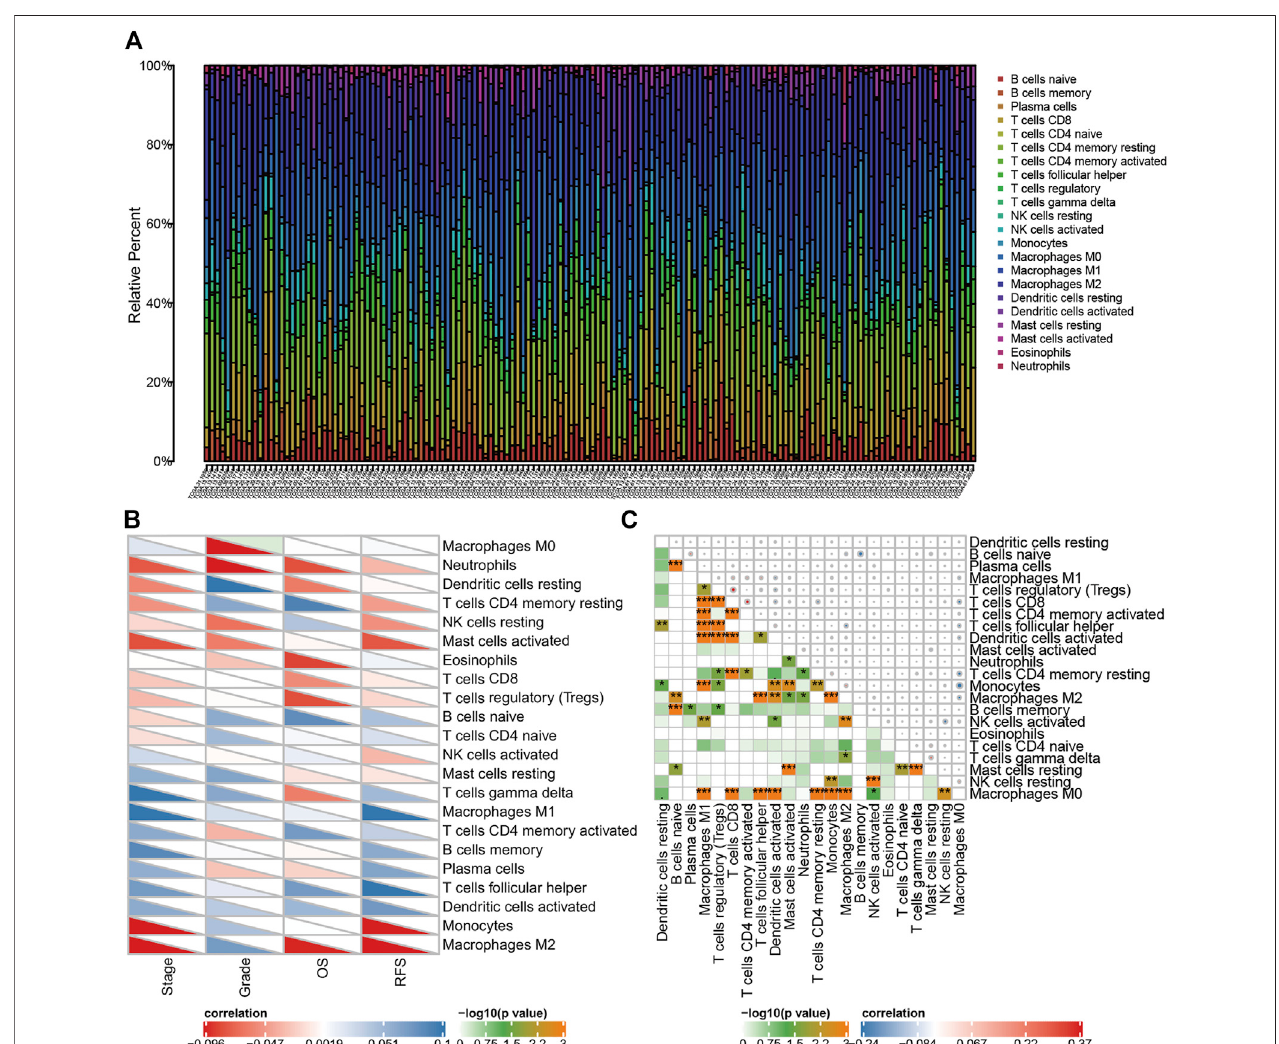
FIGURE2| Distribution oftumor immunecellsinOCpatients,and therelationshipbetweenimmune in fi ltrationcellsandclinicalfeatures. (A) Proportionof22kinds of TIICs in TCGA OC samples was shown in the bar plot. Horizontal axis represents different patient samples and the vertical axis represents the percentage of TIIC. (B) Correlation of 22 TIICs with clinicopathologic-grade characteristics was calculated by Pearson ’ s correlation test. (C) Correlation among 22 kinds of TIICs. Color in the lowerleftcornerrepresentsthesizeofthe p- value,andthesizeandcolorofthecircleintheupperrightcornerrepresentPearson ’ scorrelationcoef fi cient.* p < 0.05, ** p < 0.01, and *** p <